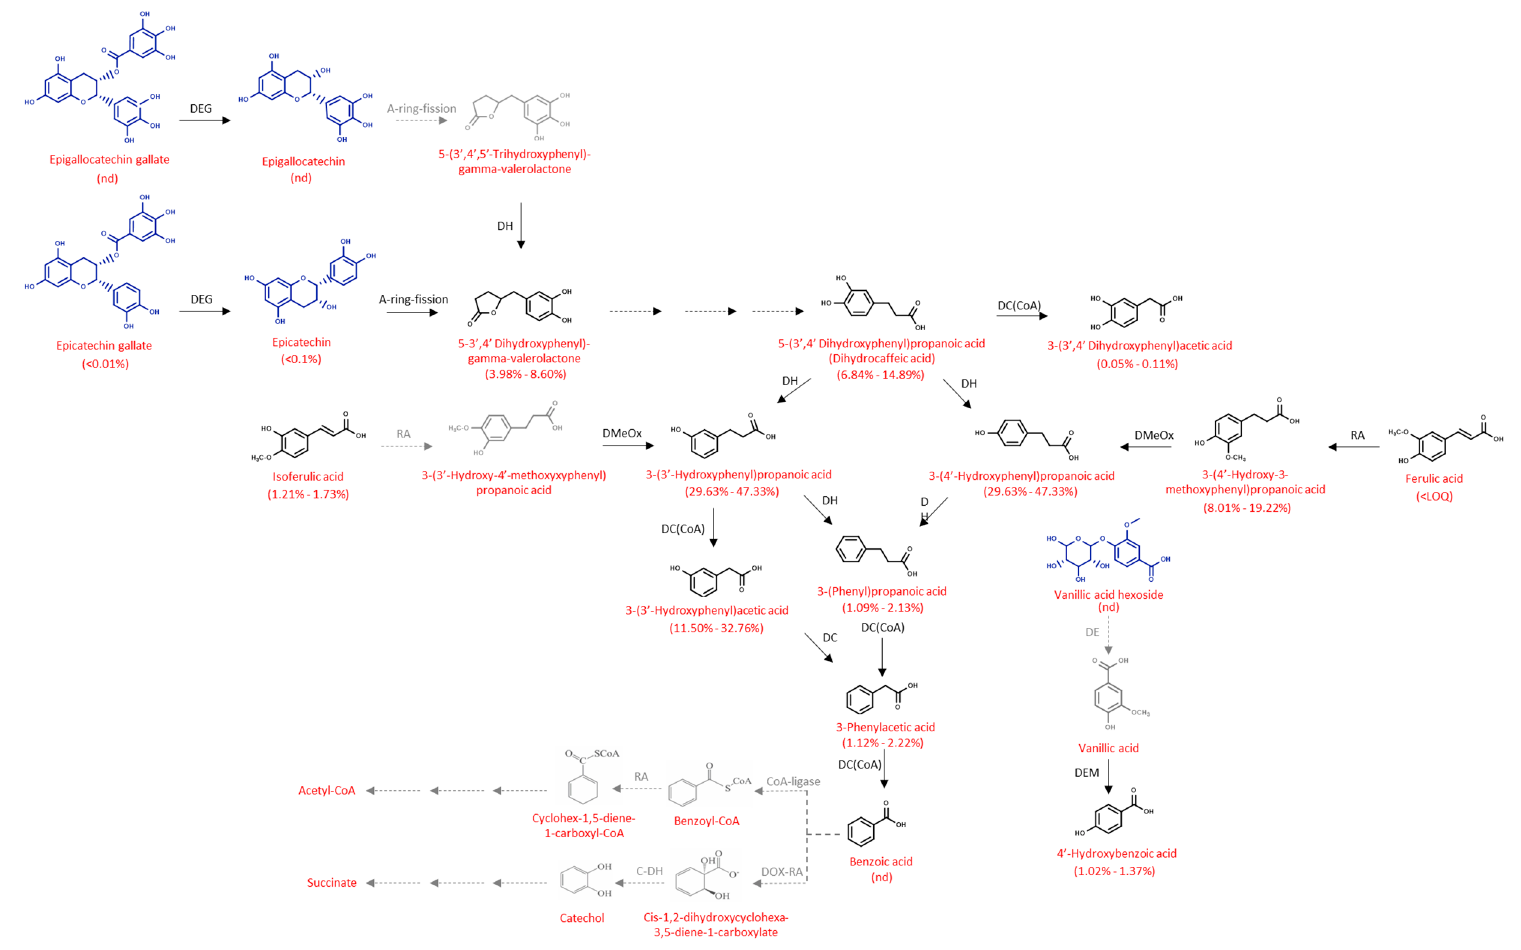
Figure 2. Tentative catabolic pathway for pistachio polyphenols by the colonic microbiota. Compounds in blue were presented before fecal fermentation, compounds in black were formed during fecal fermentation and compounds in dotted line were not detected. DEG: degalloylation; DES: de-esterification; DC: decarboxylation; RA: reductase; DMeOx: de-methoxyesterase; DH: dehydrogenase; DEM: demethylation; DOX-RA: dioxygenase reductase; C-DH: carboxylate dehydrogenase. The recovery ranges (%) of each compound are included for the six pistachio varieties after 24 h of in vitro fermentation.